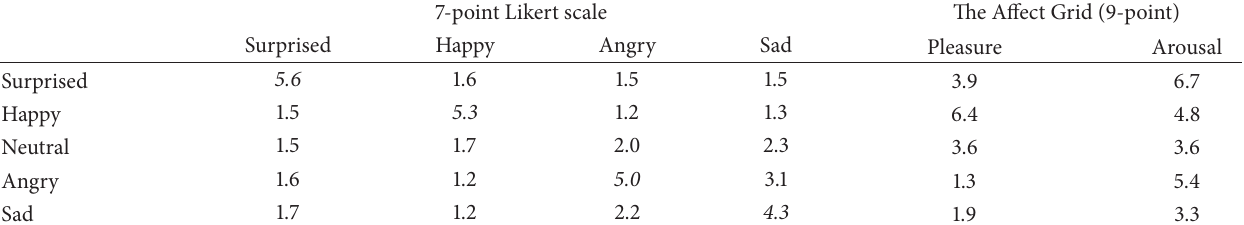
Table 1: Mean ratings for emotions, pleasure, and arousal for a stimuli based on a 7-point scale and an affect grid (9-point scale). 7-point Likert scale The Affect Grid (9-point)